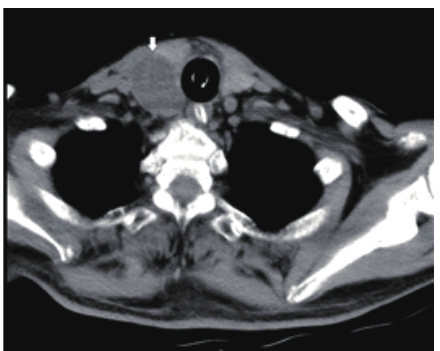
Figure 2 CT scan of the neck revealed the cyst was located behind the right lobe of the thyroid gland.